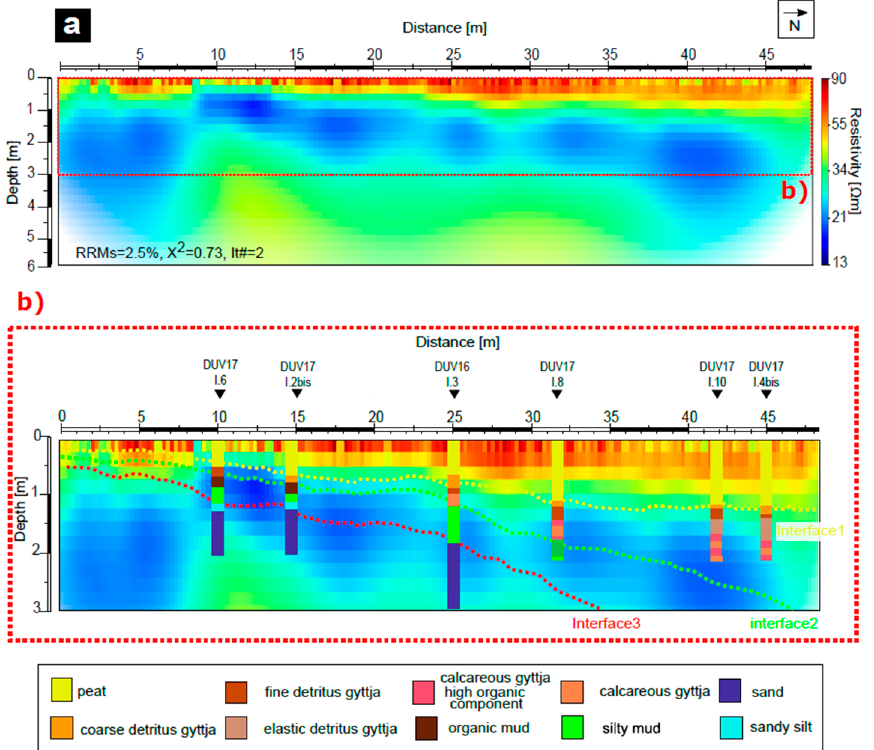
Figure 6. Results of the geoelectric measurements: ( a ) resistivity tomography of the reference profile; ( b ) focus on the uppermost 3 m of the resistivity tomography together with the stratigraphy and the GPR interfaces (Interface1, Interface2, Interface3).